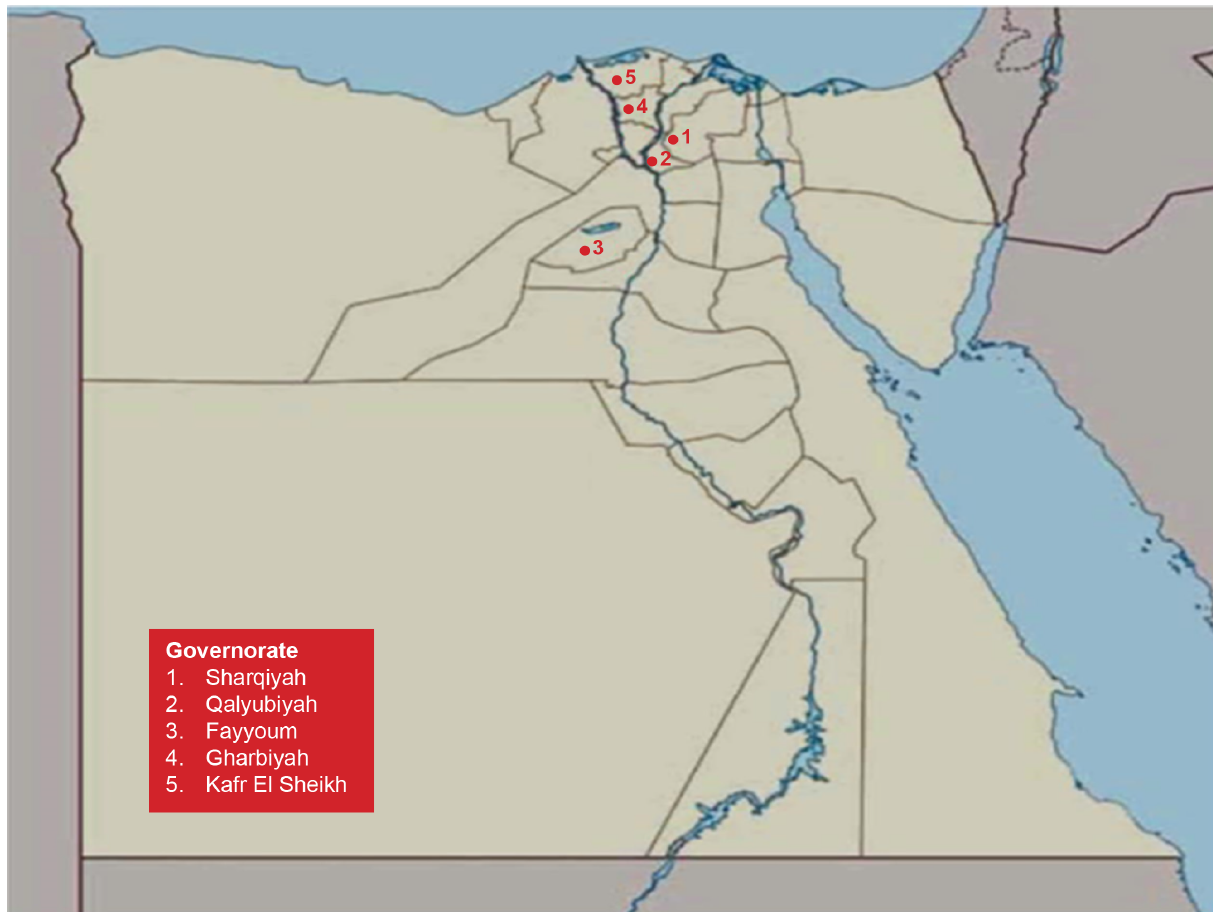
Figure 1. Map showing locations of the study